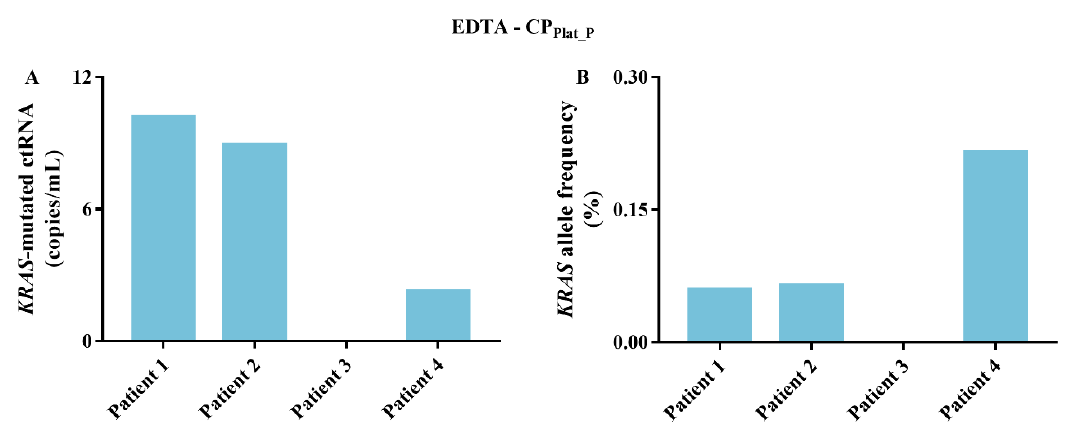
Figure 5. ctRNA analysis of KRAS -mutated metastatic cancer patients (4). ( A ) Concentration of KRAS -mutated ctRNA (copies/mL); ( B ) KRAS -mutated ctRNA allele frequency (%).